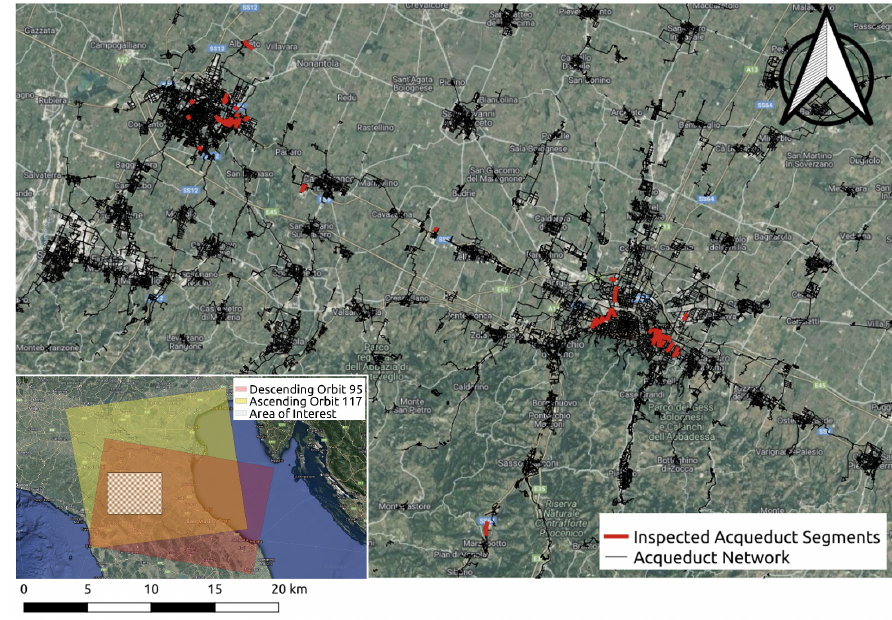
Figure 2. The study area is located in the provinces of Bologna and Modena, Northern Italy. The aqueduct network is represented in black, the parts examined by human experts in